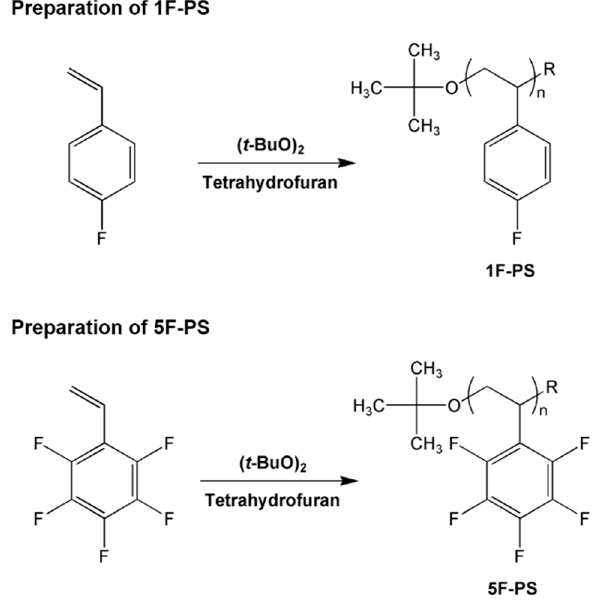
Figure 1. Preparation of Ps, 1F-PS(poly(4-fluorostyrene)) and 5F-PS(poly(2,3,4,5,6-pentafluorostyrene)).